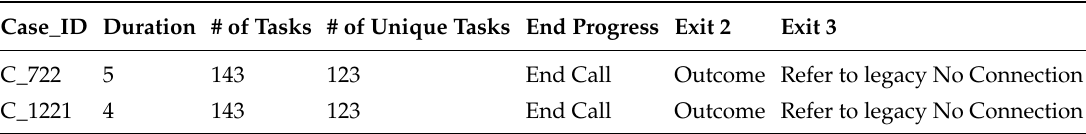
Table 5. Most similar cases identified by the Gower Distance Matrix.